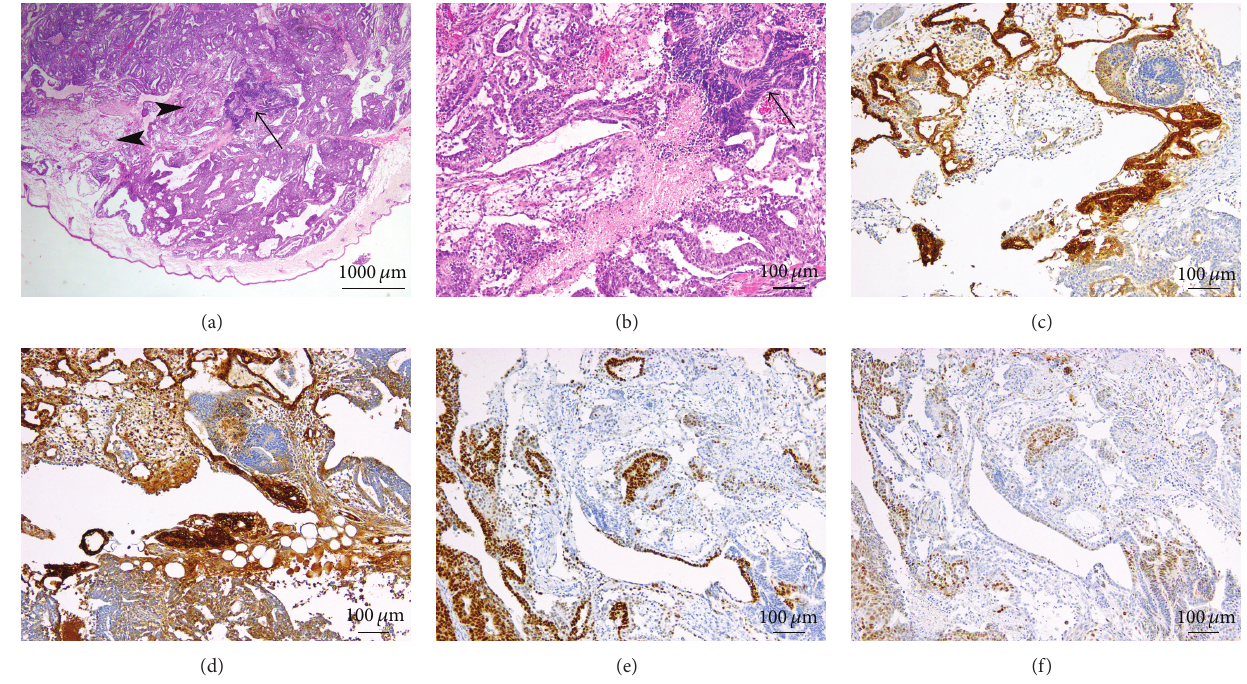
Figure 6: iPSC generated from CD34+ hematopoietic stem cells. One of the three clones produced a partly solid tumor mainly composed (95%) of an embryonal carcinoma component (a, H&E 20x), with only rare neuroectodermal rosettes ( arrow ) and a minor yolk sac component ( arrowheads ). The yolk sac component consisted in a loose meshwork of primitive-appearing cells lining cystic spaces ( arrow : neuroectodermal rosettes) (b, H&E 100x). Whereas strong reactivity for GPC3 (c, 200x) and AFP (d, 200x) was seen in the yolk sac tumor component, reactivity for OCT4 (e, 200x) highlighted the embryonal carcinoma component only. MYC staining was moderate in the embryonal carcinoma cells, whereas no reactivity was seen in the yolk sac component (f,